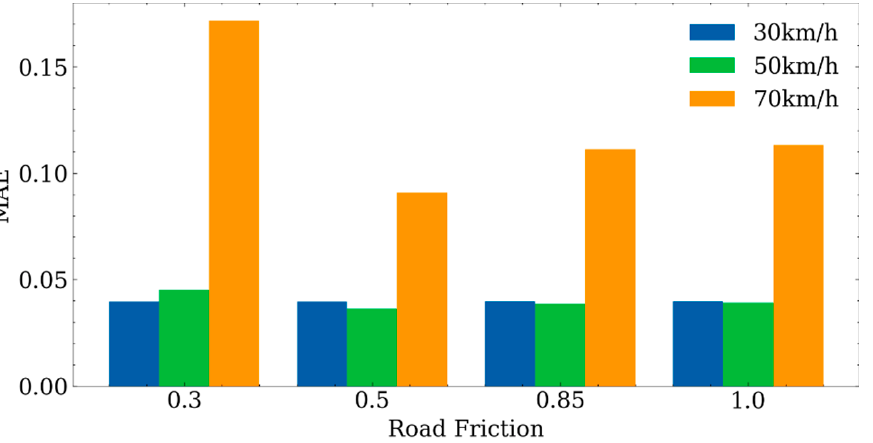
Figure 10. MAE of the prediction vs. the reference.